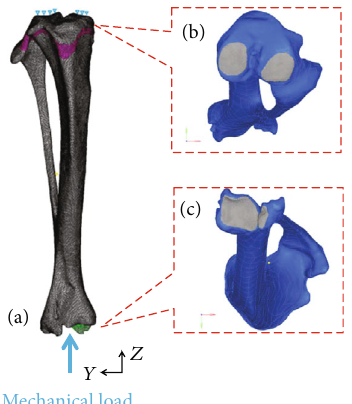
Figure 6: Typical fi nite element model of the rat tibia: (a) boundary and loading conditions of the fi nite element model; (b) the fi xed bone surface on the tibial plateau; (c) the selected surface for mechanical load on the distal